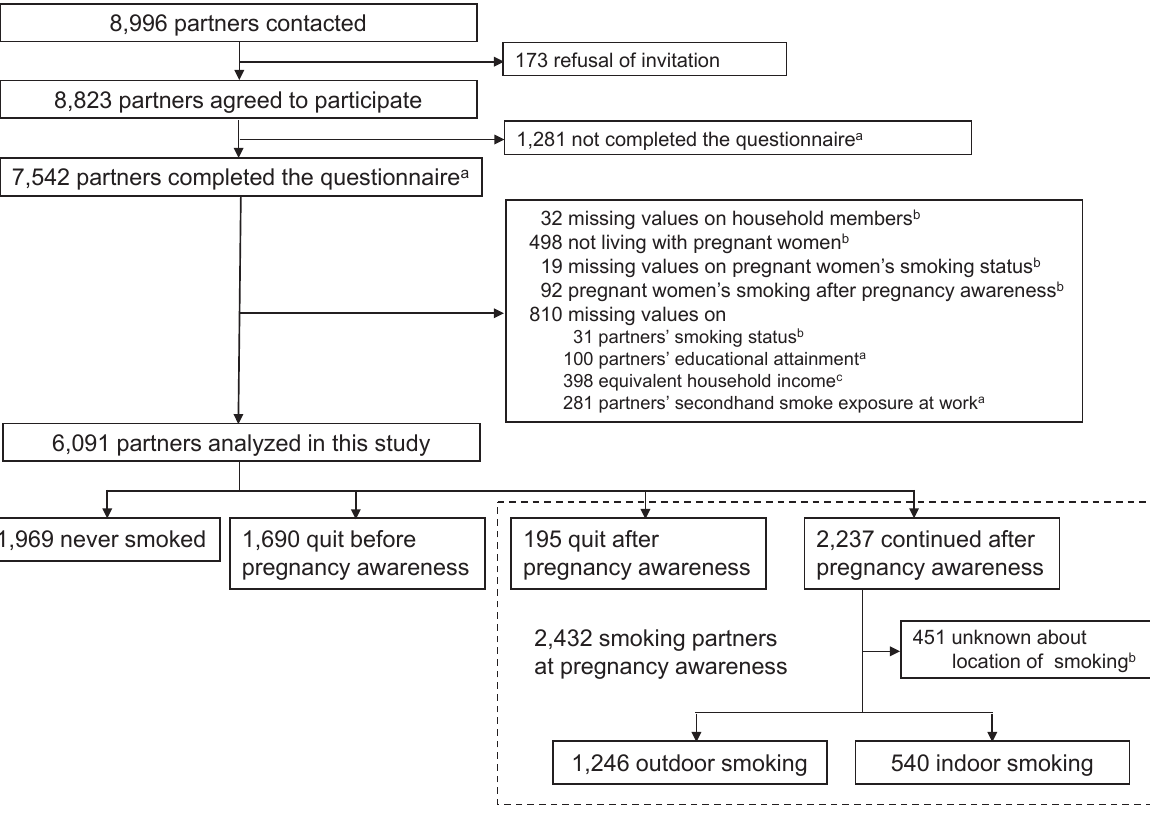
Figure 1. Flow diagram of participants in the present analysis of the Tohoku Medical Megabank Project Birth and Three- Generation Cohort Study. a Data on partners ’ educational attainment and secondhand smoke exposure at work were obtained using the questionnaire administered for partners at enrollment. b Data on living with pregnant women, pregnant women ’ s smoking history, partners ’ smoking status, number of household smokers, and number of smokers inside the residence were obtained using the questionnaire administered for pregnant women in early pregnancy. c Data on equivalent household income were obtained using the questionnaire administered for pregnant women in middle